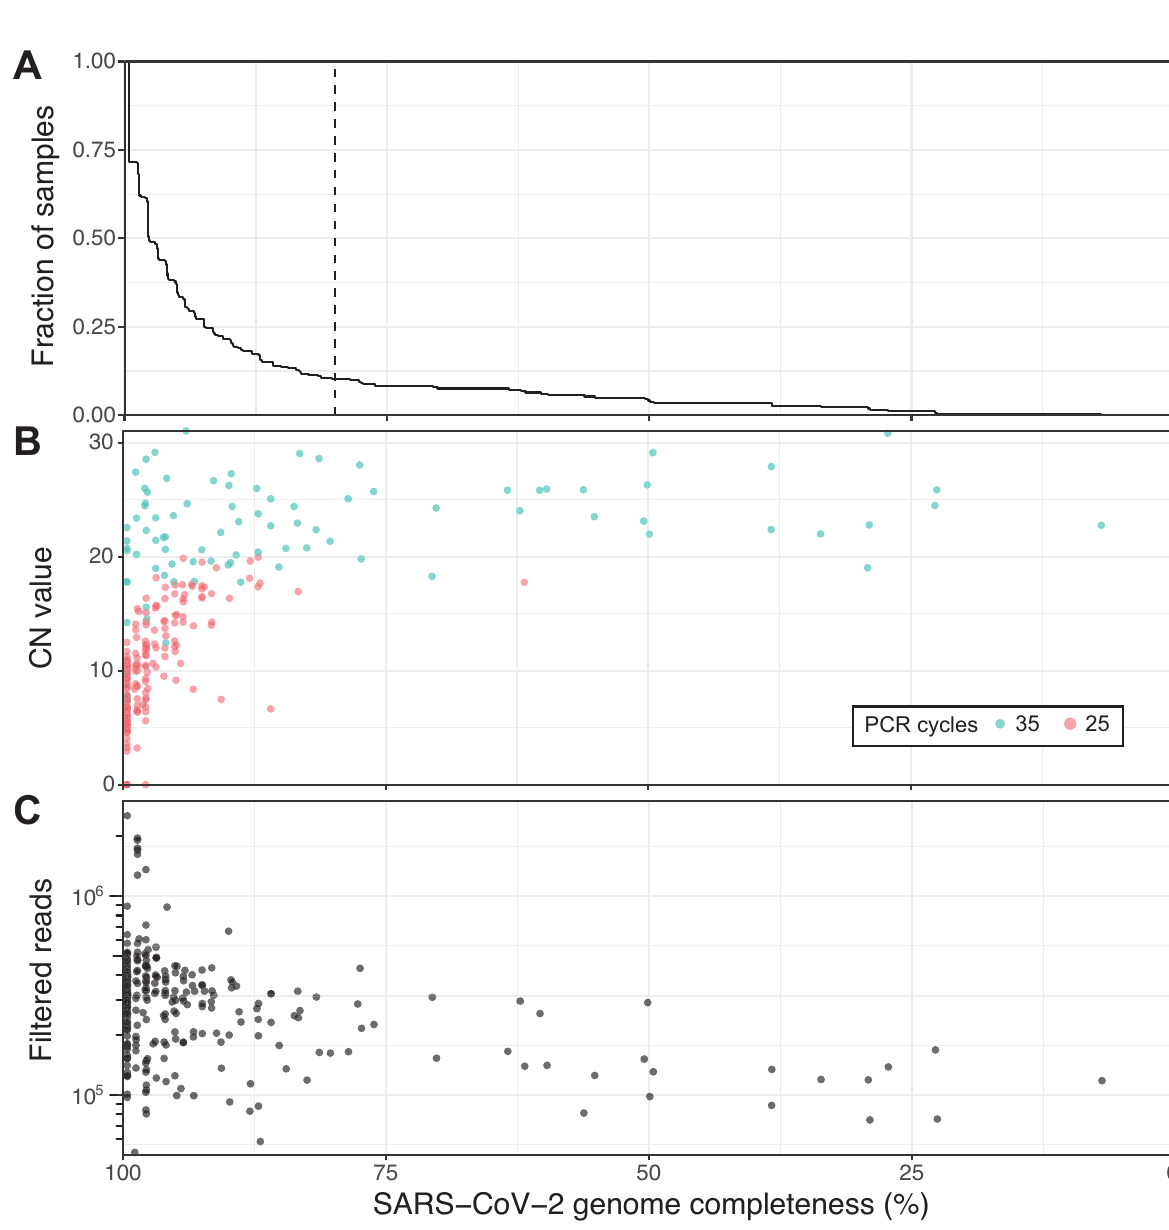
Fig 1. Viral genome sequencing of 264 SARS-CoV-2 samples with Oxford nanopore. (A) Cumulative distribution of genome completeness using the ARTIC bioinformatics SOP (see methods). Dashed vertical line corresponds to the 80% completeness threshold used for phylogenetic reconstruction. (B) Relationship between CN score at diagnosis, as measured by the Abbott RealTime M2000rt device (higher CN = lower viral load), and genome completeness. (C) Relationship between number of quality passed reads filtered using the ARTIC bioinformatics SOP and genome